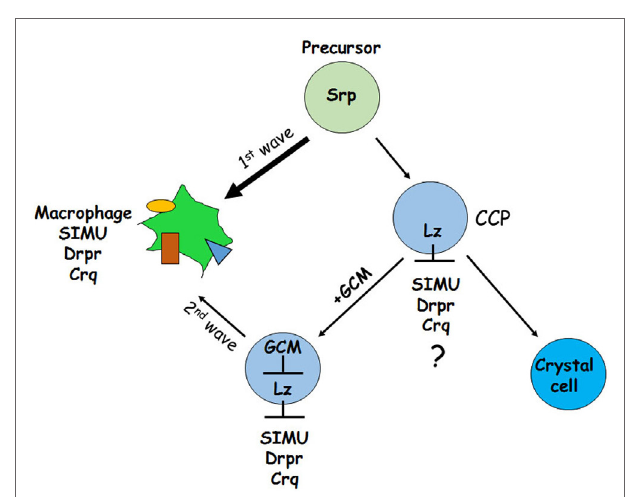
FigUre 12 | Schematic representation of two waves regulating development of embryonic macrophages. First wave starts from general Srp-positive hemocyte precursors and second develops from Lz-positive crystal cell precursors (CCPs). During the first wave Srp regulates SIMU, Drpr and Crq expression in plasmatocytes with no involvement of GCM,GCM2 and Lz. In the CCPs Lz expression likely (?) inhibits SIMU, Drpr and Crq expression resulting in formation of crystal cells that do not express these receptors. The second wave evolves from CCPs where GCM,GCM2 repress Lz, which allows expression of SIMU, Drpr and Crq and formation of macrophages. Srp may regulate additional factors involved in macrophage differentiation.